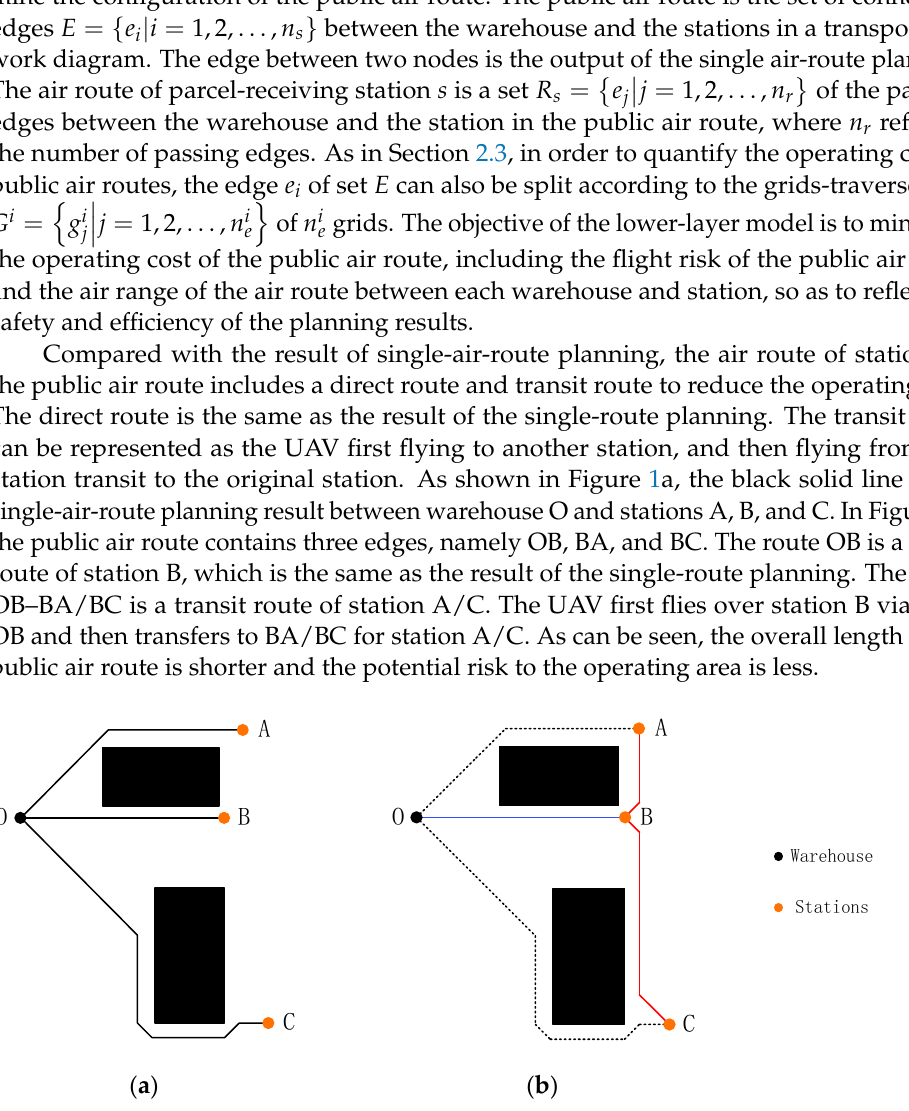
Table 4. New parameters for parcel-receiving station and public air-route planning formulation de- fined.